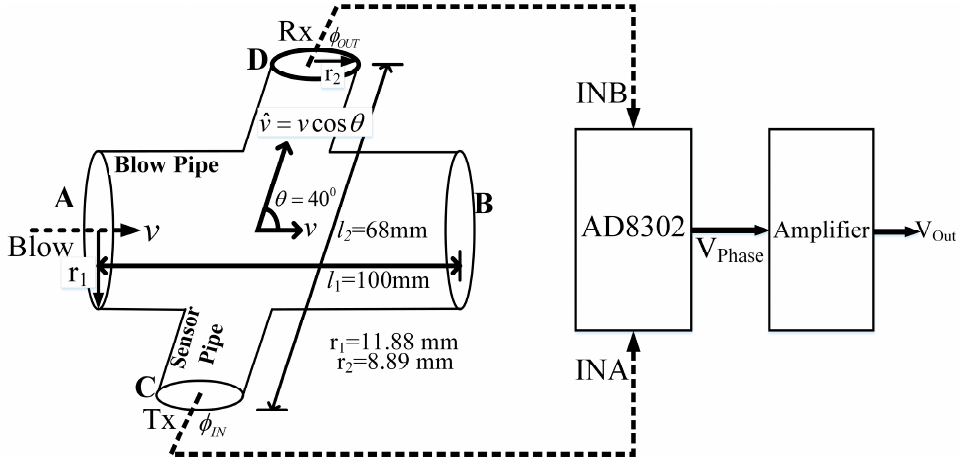
Figure 4. The flow pipe arrangement for phase detection to comprehend respiration flow.